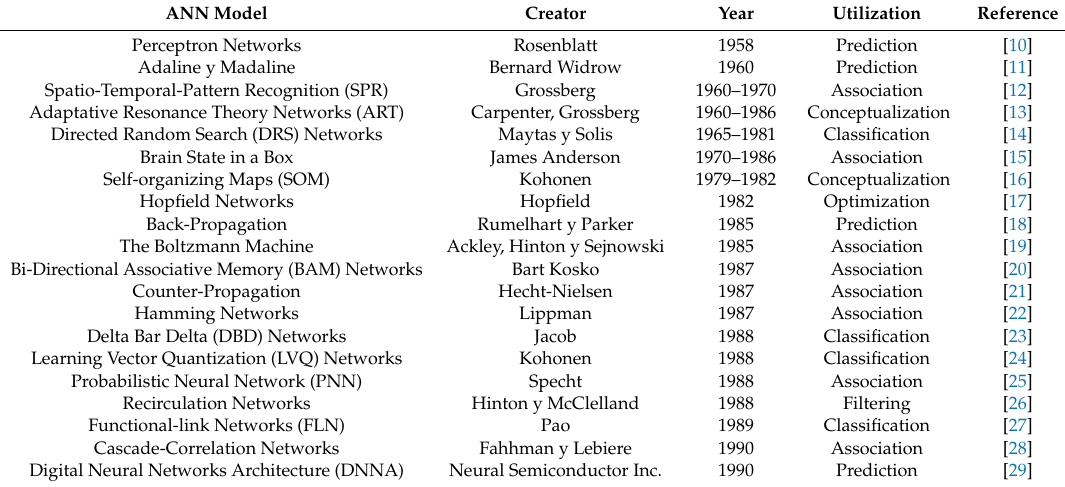
Table 1. Catalogue of initial Artificial Neural Network (ANN)